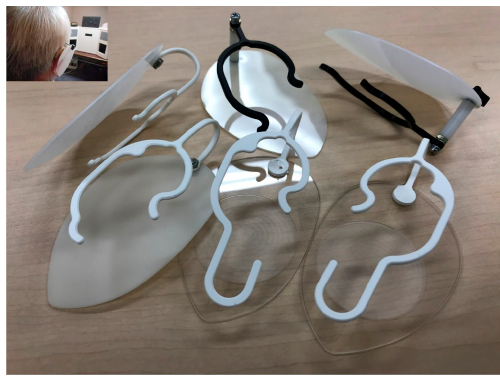
Figure 9. Non-electric hearing aids (Japanese Patent No. 6082676).